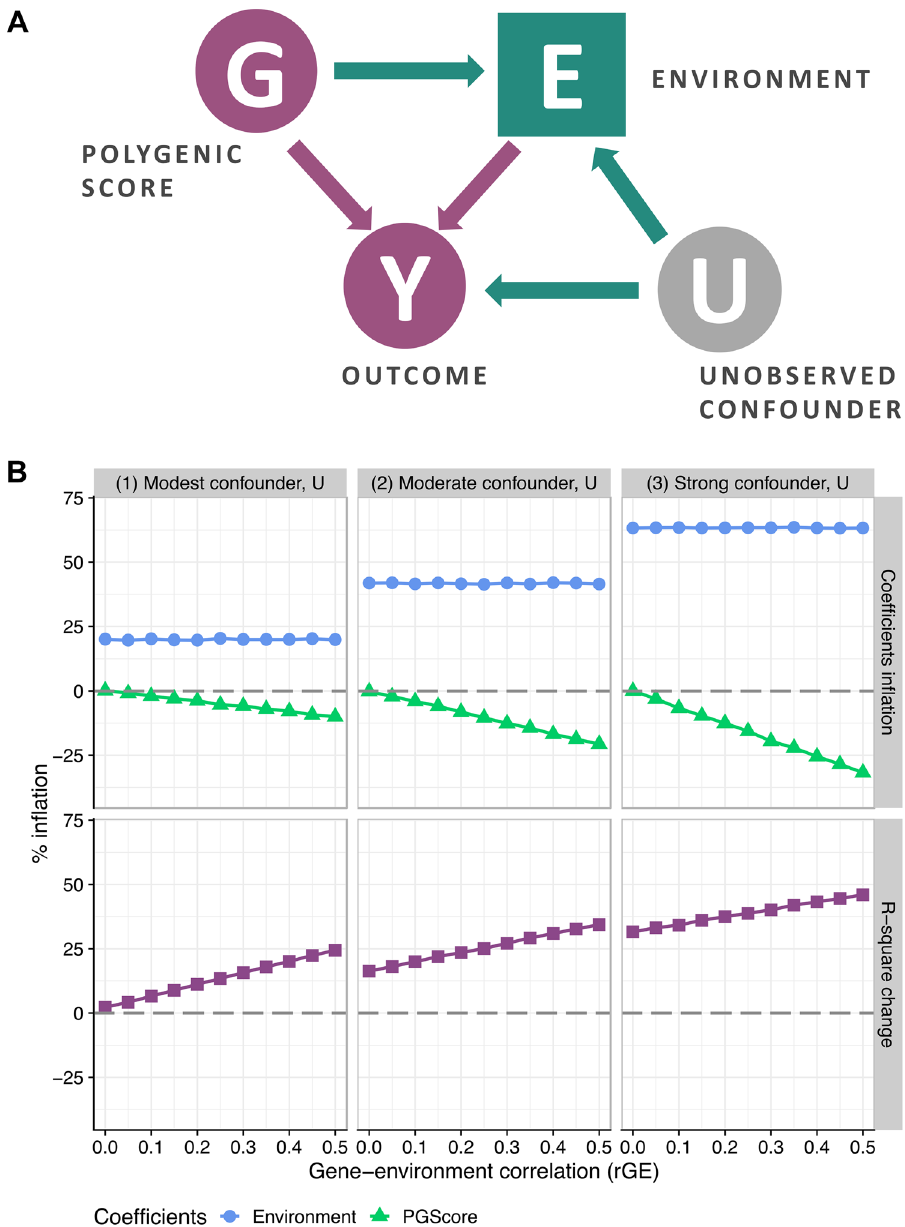
Figure 1. Collider bias in polygenic gene-environment models. Panel A. Schematic diagram of the collider bias which occurs between polygenic score, environment, and outcome in cases of gene-environment interdependence. Dark purple circles represent variables, unobserved confounders are shown in grey circles, collider variables are indicated by squares. By adding E into the model with the polygenic score G, we make E a collider. A collider that is not conditioned on, blocks the path between its sources (G and U); once a collider is controlled for, the path is opened as indicated by green nodes. Panel B (top). Spurious regression estimates for polygenic score and environment from the series of OLS simulations reflecting the range of gene-environment interdependence and the presence of modest, moderate, or strong confounder, U. Collider bias due to positive values of gene-environment correlation and the presence of uncontrolled confounder, which is positively correlated with covariate and outcome, results in deflation of polygenic score estimates. The degree of bias depends on the strength of unobserved confounder, U, and gene-covariate interdependence. Estimates of the environmental effect are upwardly biased but are not affected by the gene-environment correlation. Panel B (bottom). R-squared inflation plot from the series of OLS simulations; collider bias results in inflated values of explained variance statistics. R-squared statistics for the model with endogenous covariate and polygenic score includes not only the true share of the variance in Y explained by G and E (baseline estimate indicated by 0), but also the elements of variance that are due to gene-environment correlation and confounder(s),